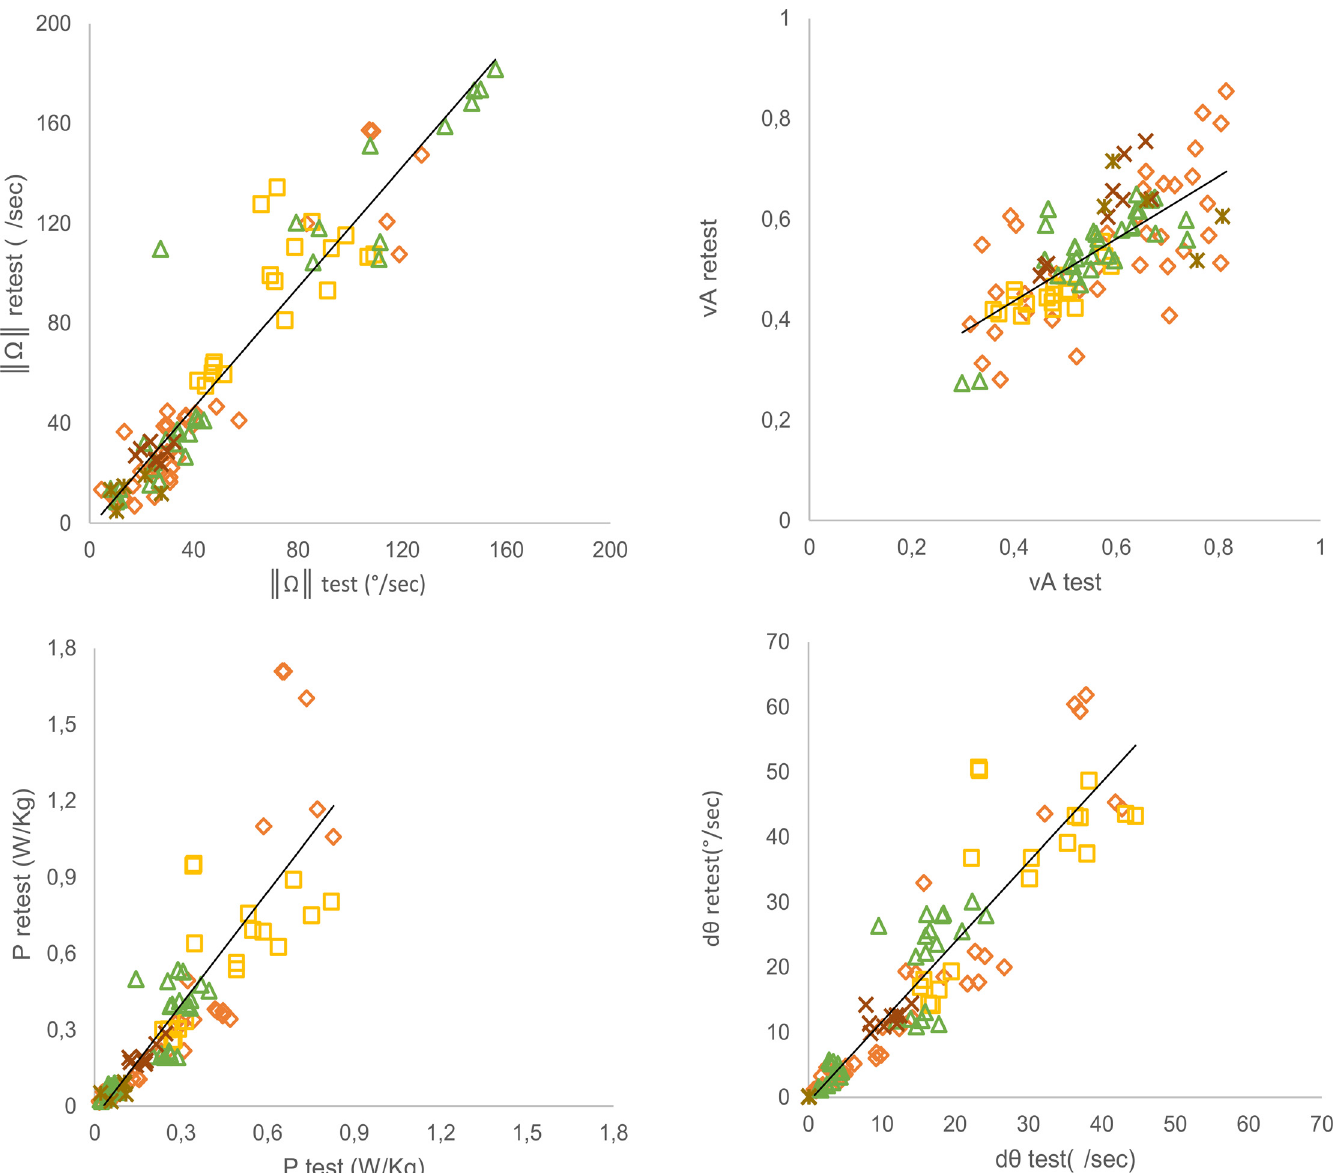
Fig 3. Reliability between test and retest for all the tasks evaluated for each ActiMyo 1 variable. (cid:3) MoviPlate; ⬜ BBT; 4 Minnesota test; * Writing; × PC